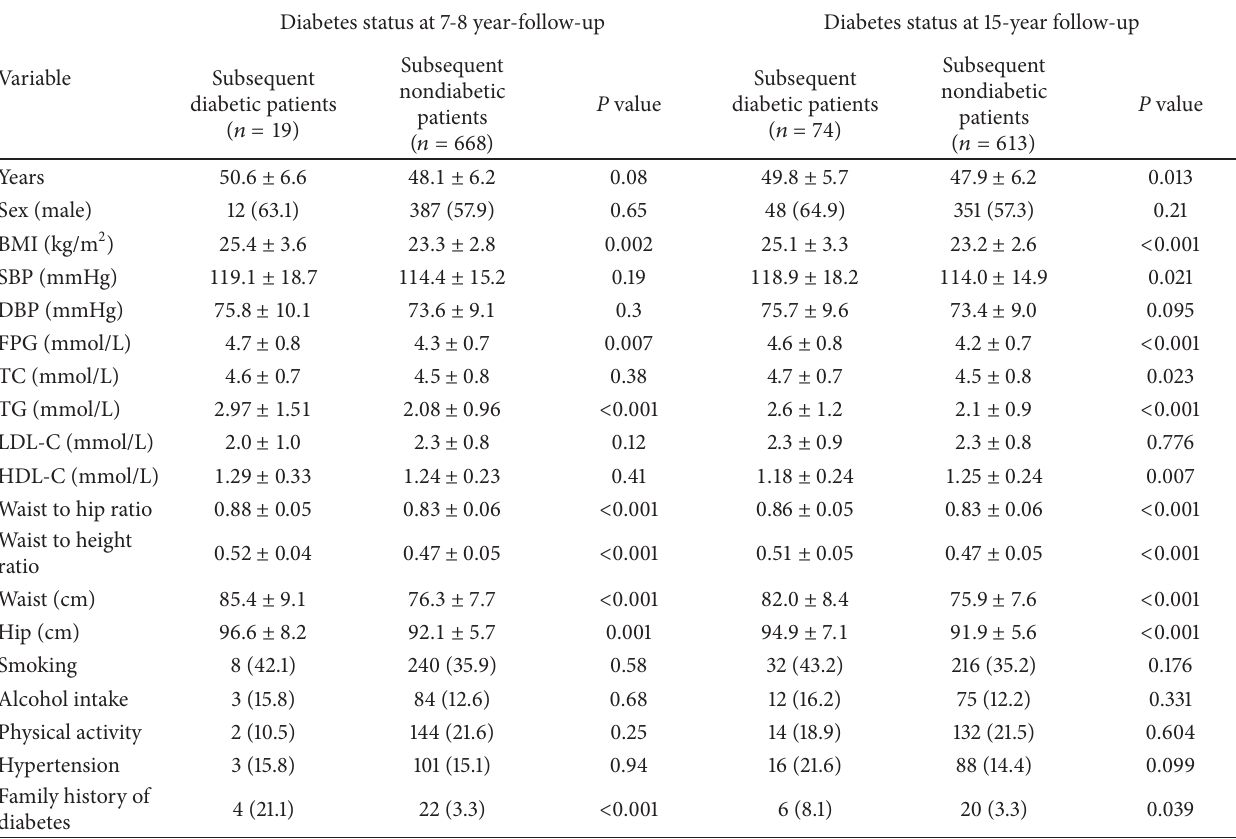
Table 1: Baseline characteristics of the population according to diabetes status at follow-up at 7-8 and 15 years.